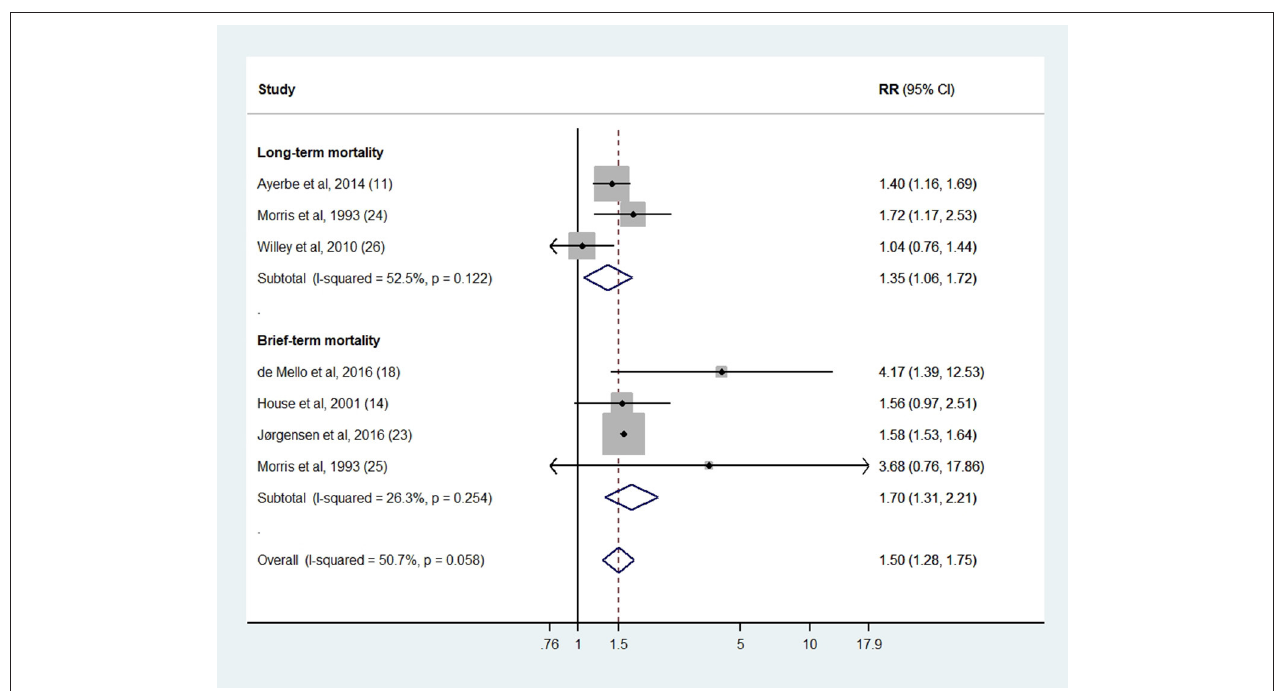
FIGURE 2 | Association between early post-stroke depression and mortality. Short-term mortality = 1 or 2 years after stroke; Long-term mortality = 5 or more years after stroke.